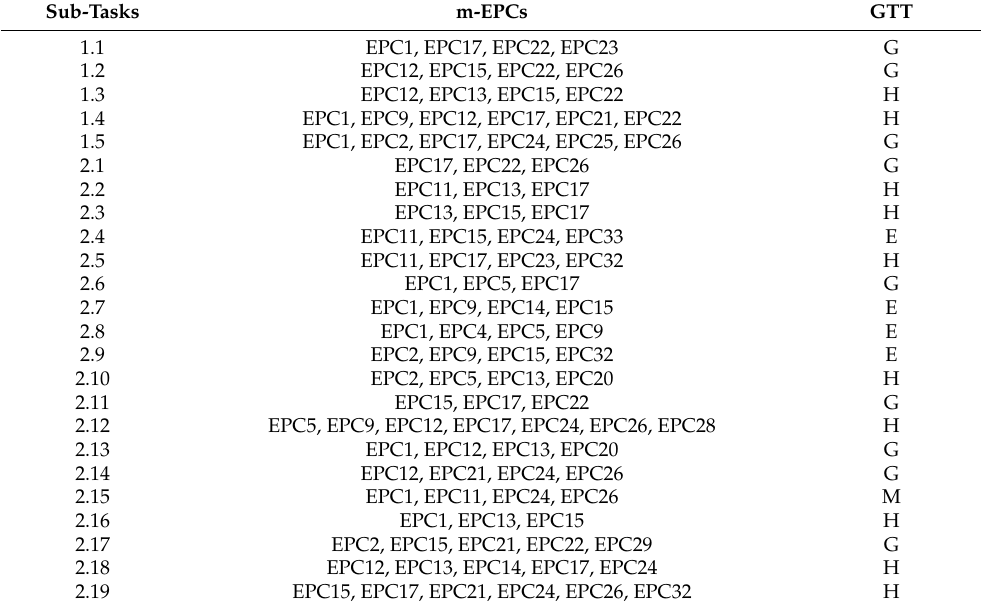
Table 4. Assigned GTT and